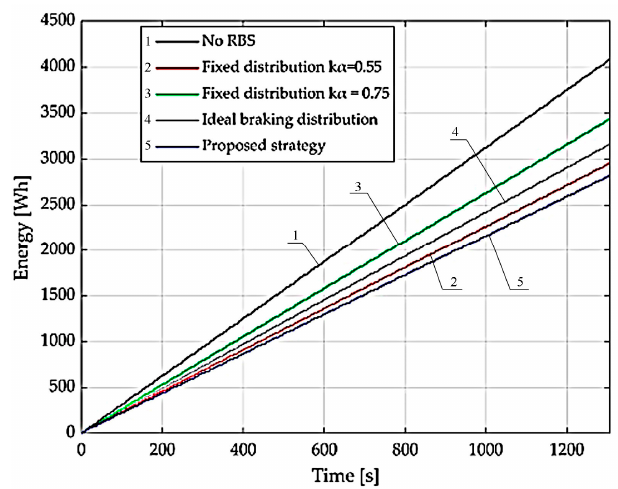
Figure 8. Comparison of energy consumption.